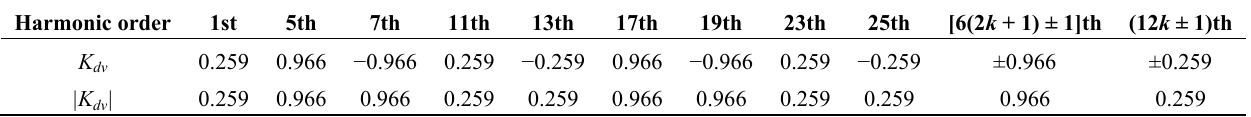
Table 3. The distributed factor for ν th MMF